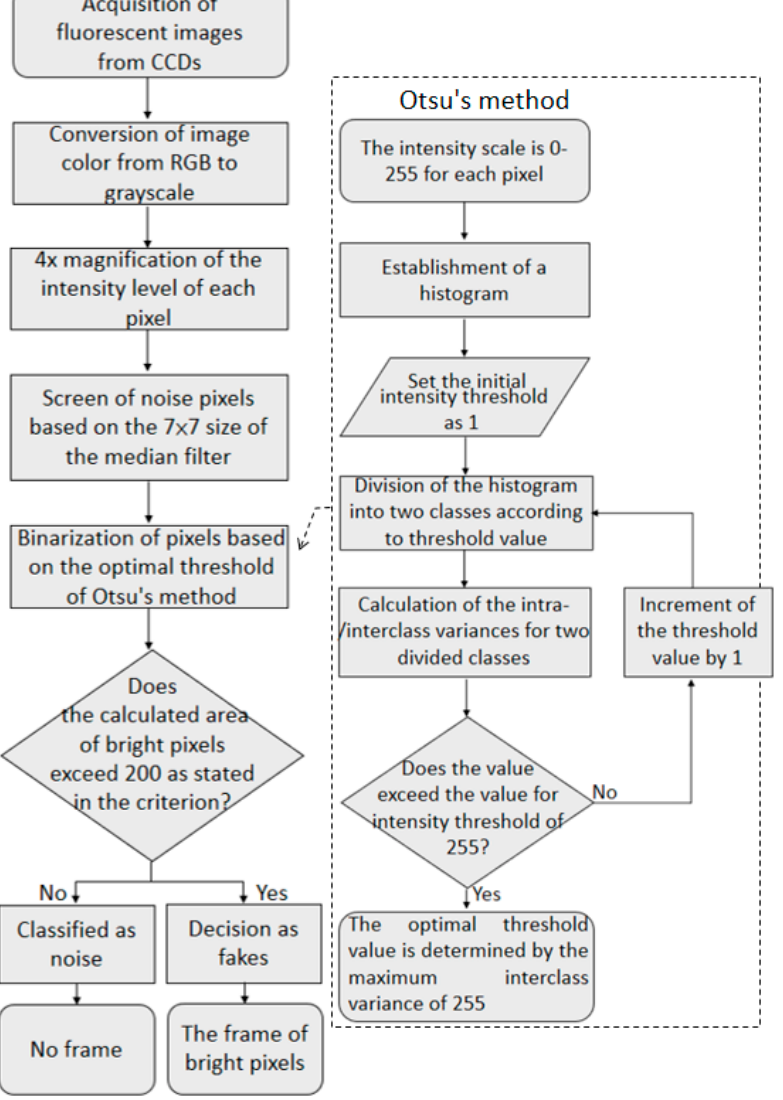
Figure 2. AI algorithm program for the generation of white rectangular markers of fish bones based on the fluorescent intensity of CCD